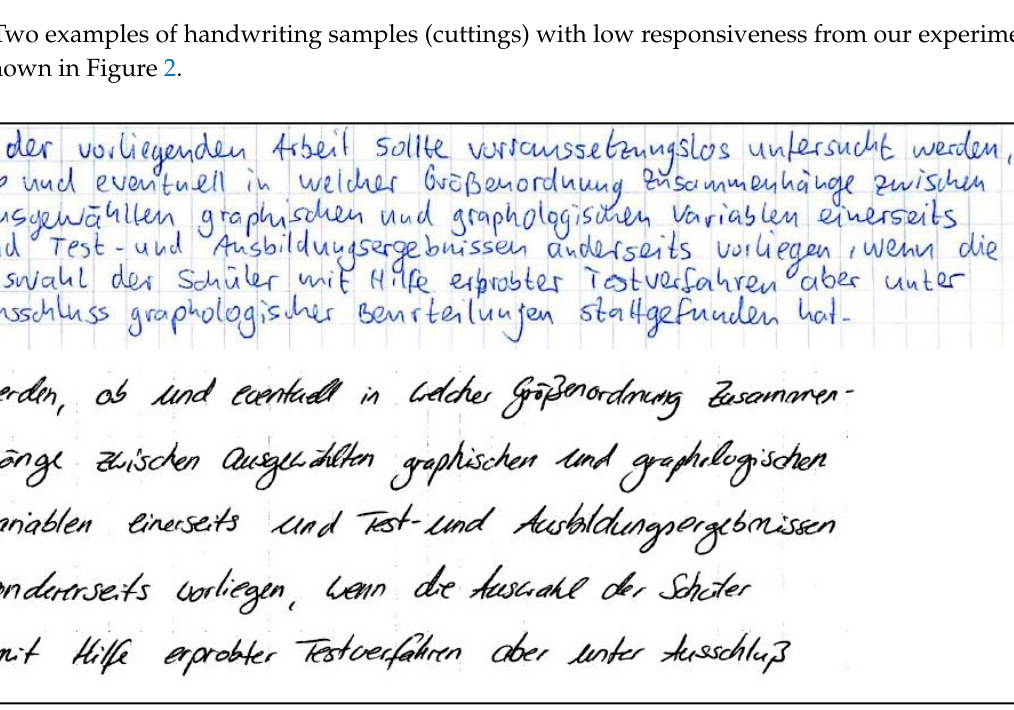
Figure 2. Handwriting samples with low responsiveness.